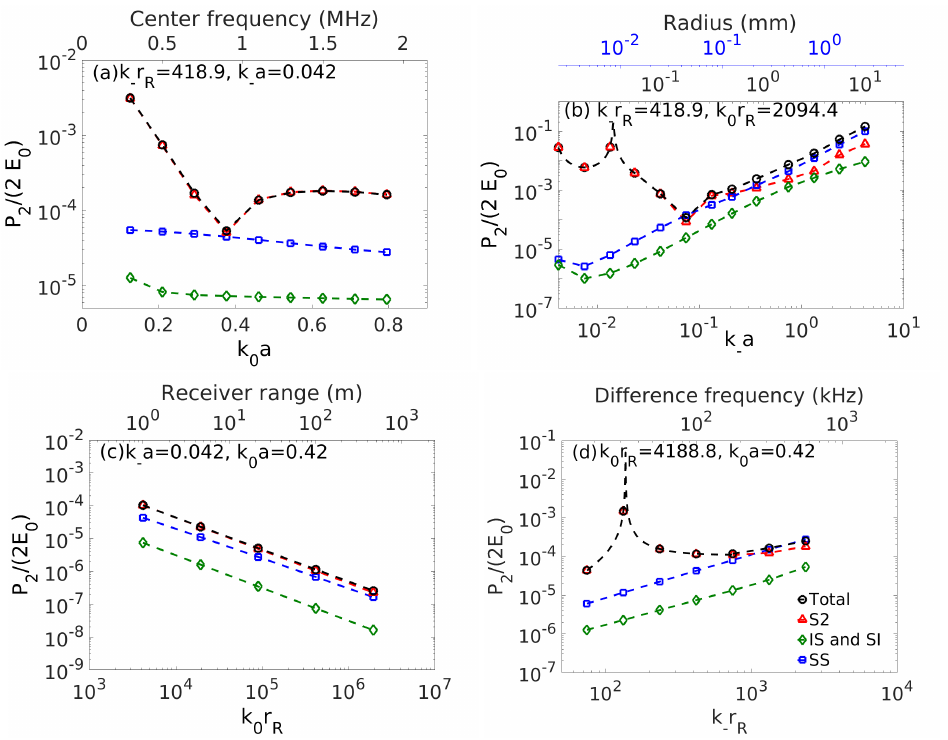
Figure 7. Same as Figure 6 but for an air bubble in water using Equation (97) for p S2 at low k − a .